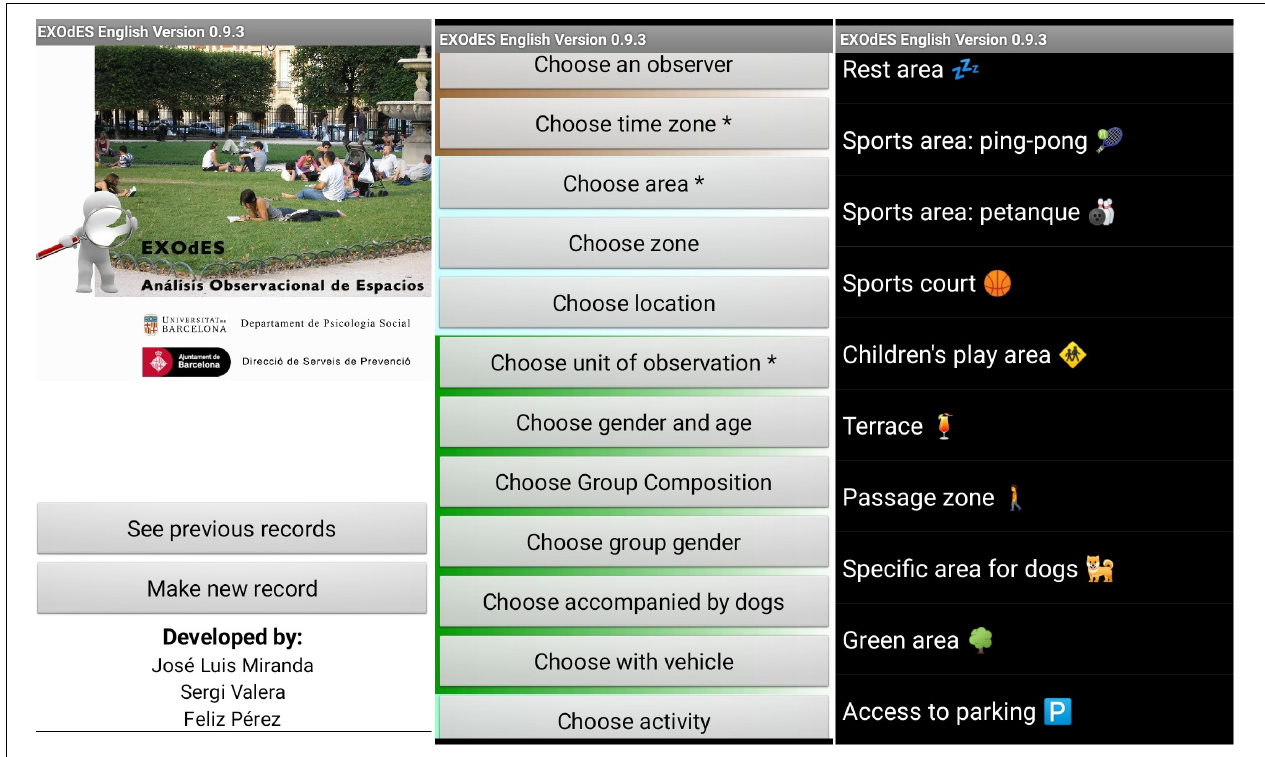
FIGURE 4 | Screenshots illustrating the EXOdES tool.